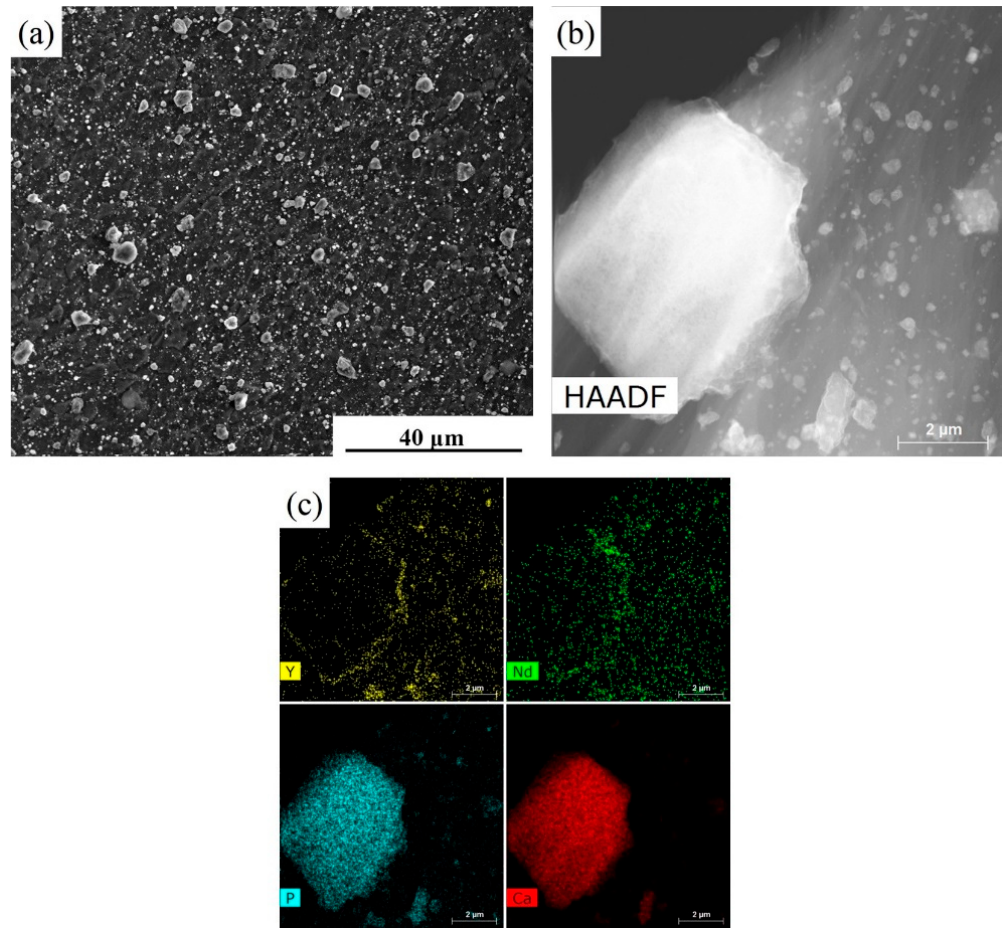
Figure 5. ( a ) SEM image; ( b ) TEM image; and ( c ) EDS analysis of the WE43/nHA specimen.